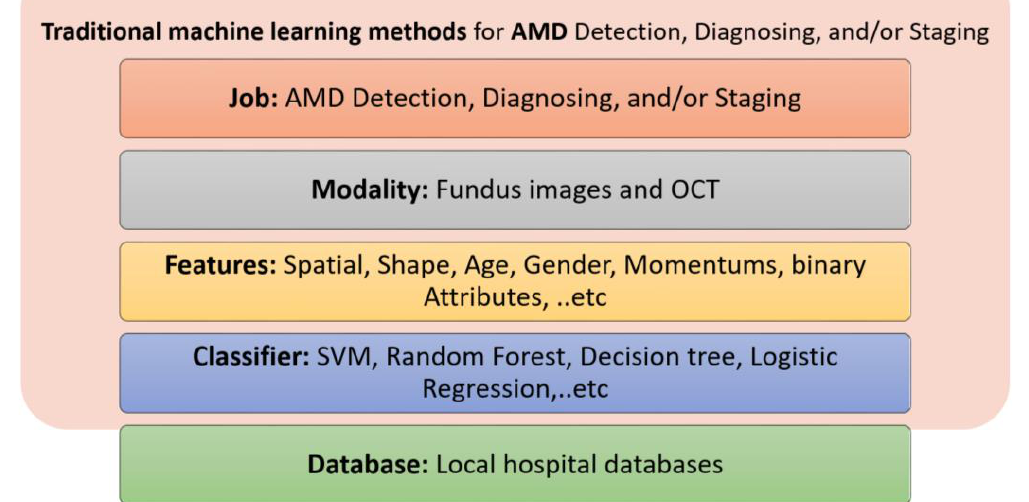
Figure 7. Summary of traditional ML methods for AMD detection, diagnosis, and/or staging.